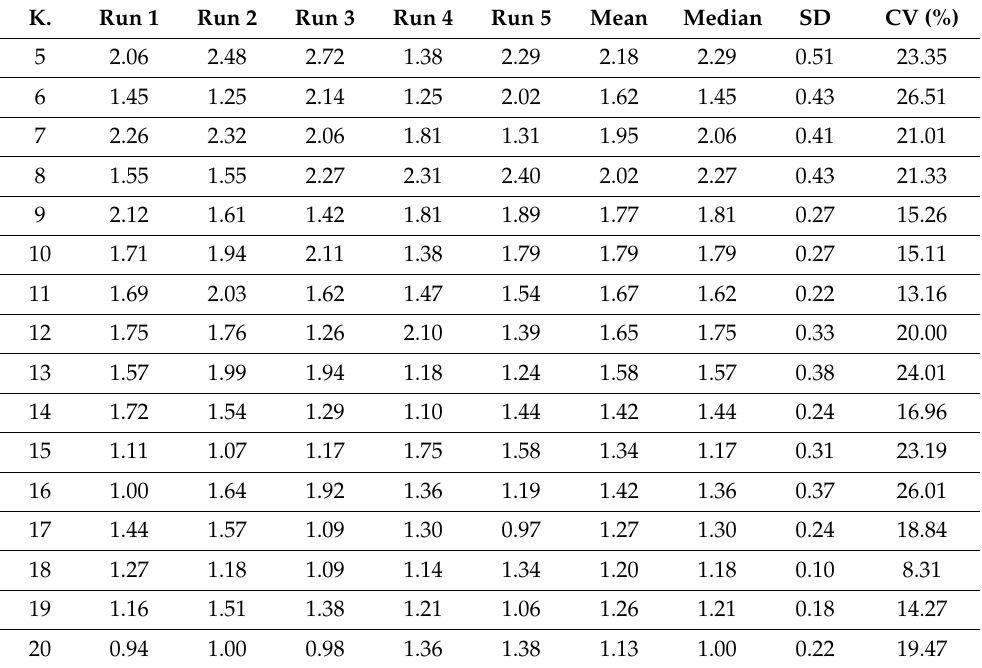
Table 2. K-scores at different